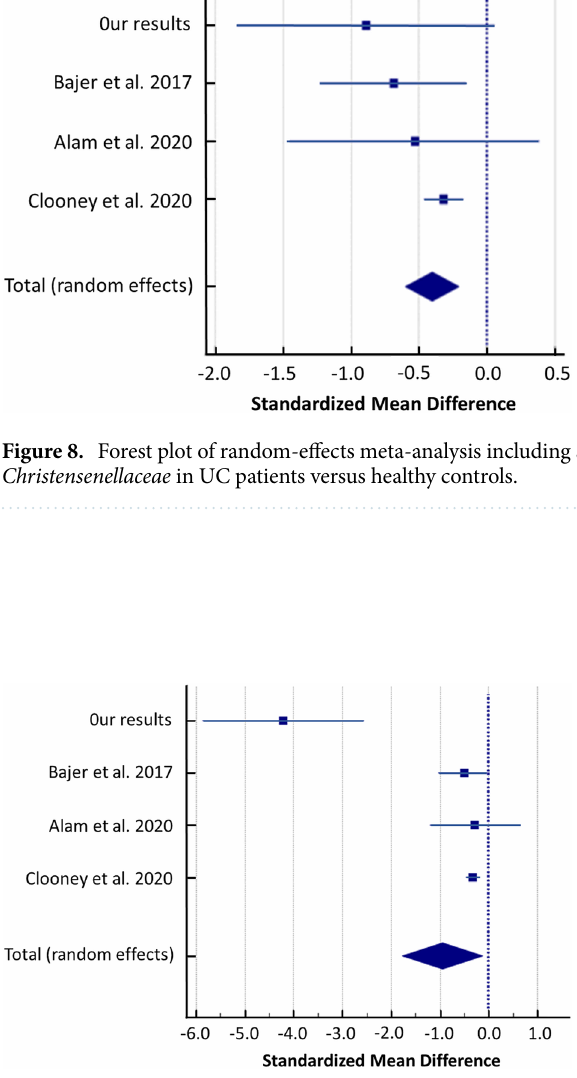
Figure 9. Forest plot of random-effects meta-analysis including studies evaluating the abundance of Phascolarctobacterium in UC patients versus healthy